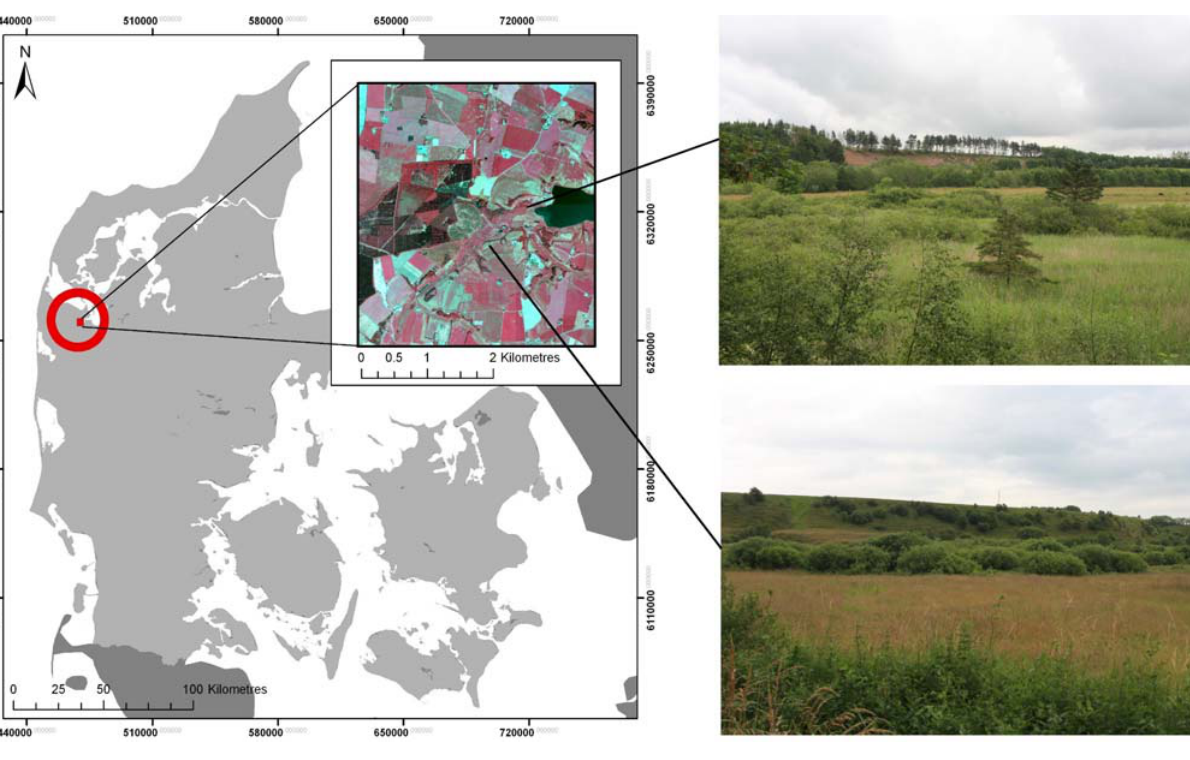
Figure 1. The study area is located in the northwestern part of Denmark and covers 14 km 2 . The two photographs to the right illustrate typical examples of shrub-encroached grassland from the study area. The applied coordinate system is the ETRS 1989 and the map projection is UTM zone